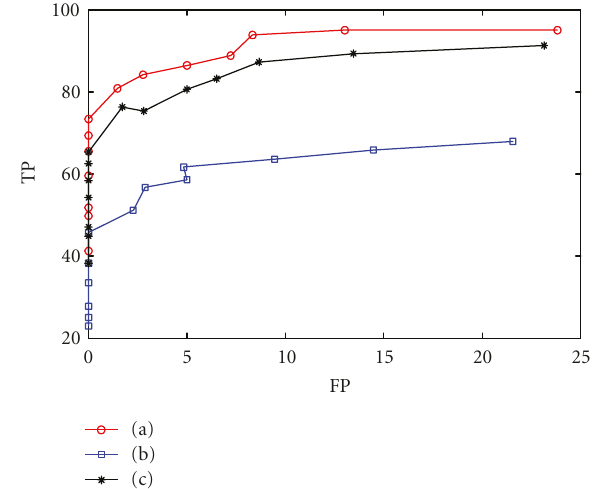
Figure 21: Average results of TP against FP for a dataset containing realistic music signals. Plots (a), (b), and (c) correspond to the proposed approach, the RMS approach, and the method in [20], where 14 di ff erent thresholds (shown as marks in each plot) were